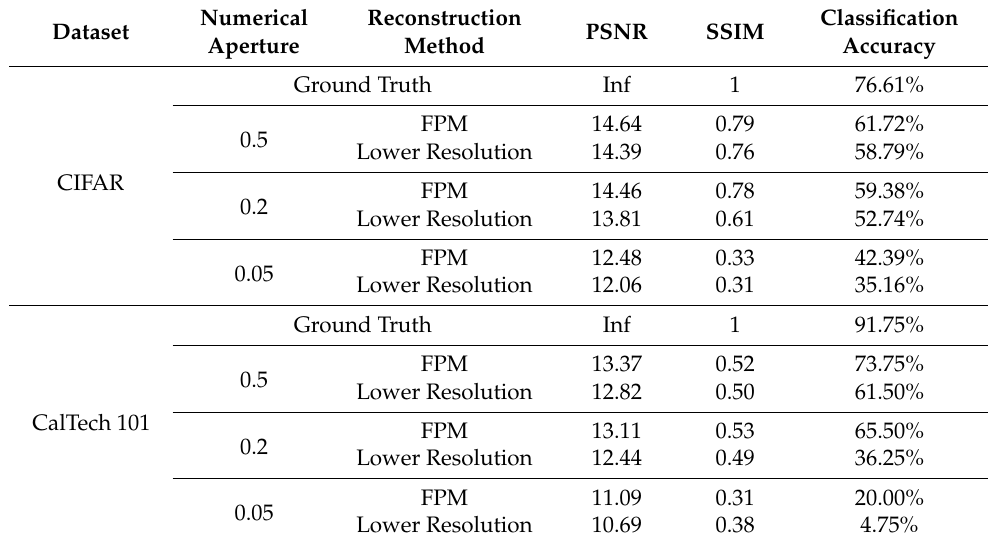
Table 1. PSNR, SSIM, and classification accuracy for CIFAR and CalTech101.